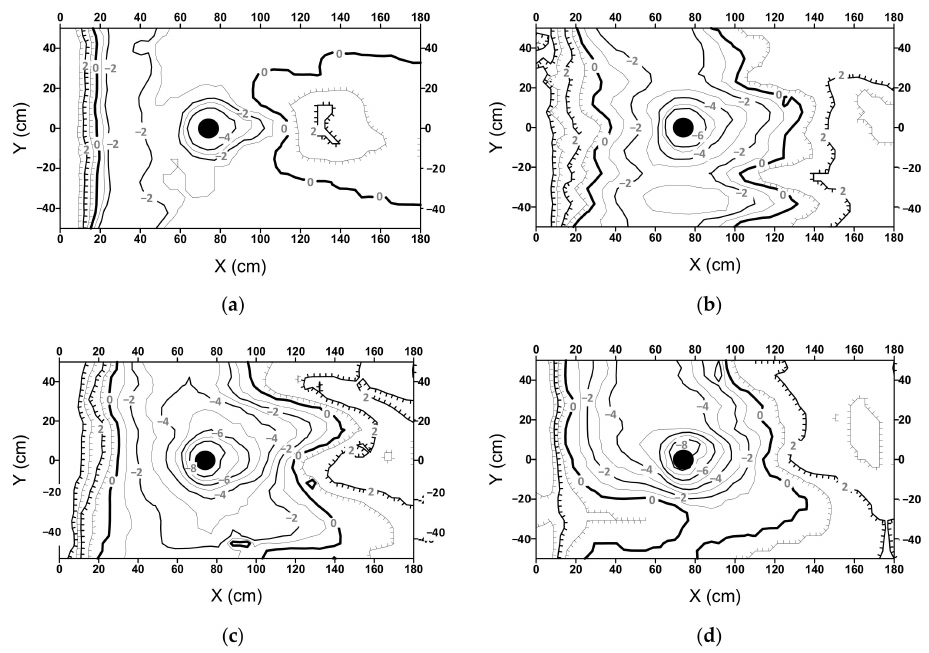
Figure 10. Sand bed changes due to different sizes of strips (the erosion and deposition contour is 1 cm; a negative value means erosion). ( a ) Case 1: D a = 0.1 mm, L = 25 cm; ( b ) Case 2: D a = 1 mm, L = 25 cm; ( c ) Case 3: D a = 2 mm, L = 25 cm; ( d ) Case 4: rectangular shape (25 mm width, 0.25 mm thickness), L = 25